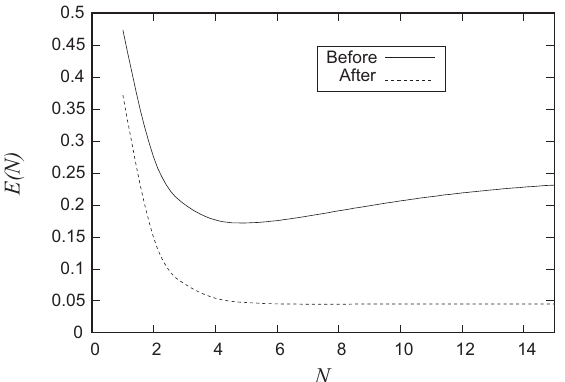
Figure 15. Dependence of the economic criterion E ( N ) on the number N before and after